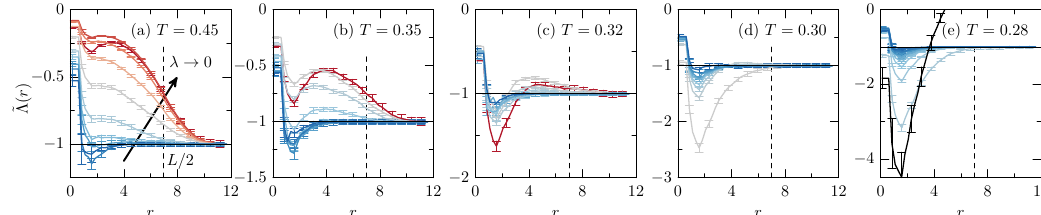
Figure 5: Energy profiles for saddles. All parameters are the same as in Fig. 3. We show the data of the QLVs only in (e). The dashed vertical lines show half of the box length L /